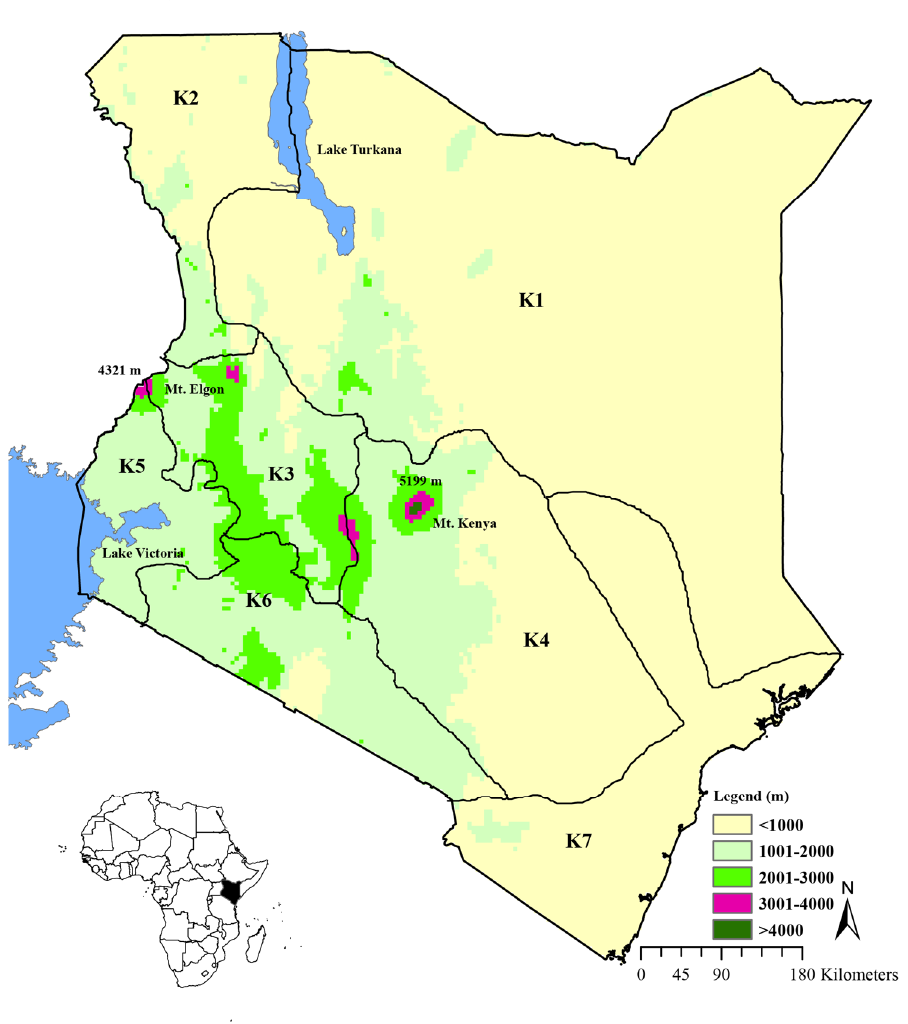
Figure 3. Map of Kenya (study area) (K1–K7 represents the seven floral regions of Kenya).